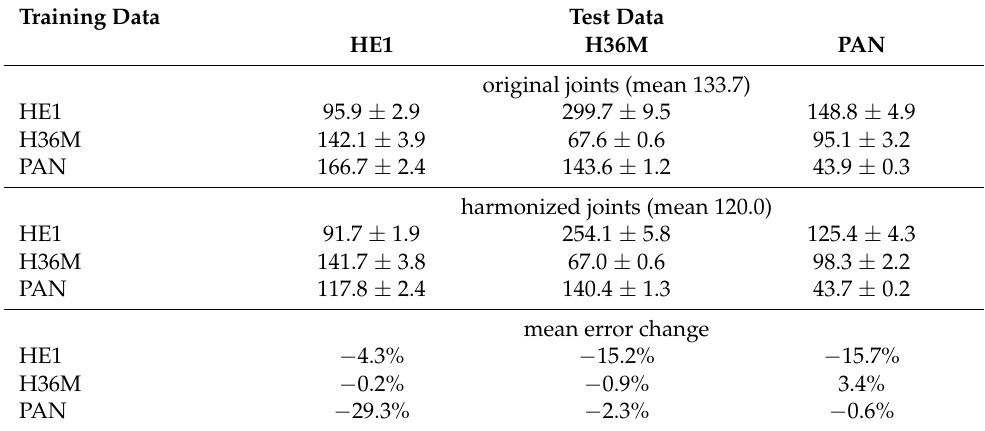
Table 7. Errors with original vs. harmonized joints (no-alignment errors in mm, mean ± std. deviation). Training